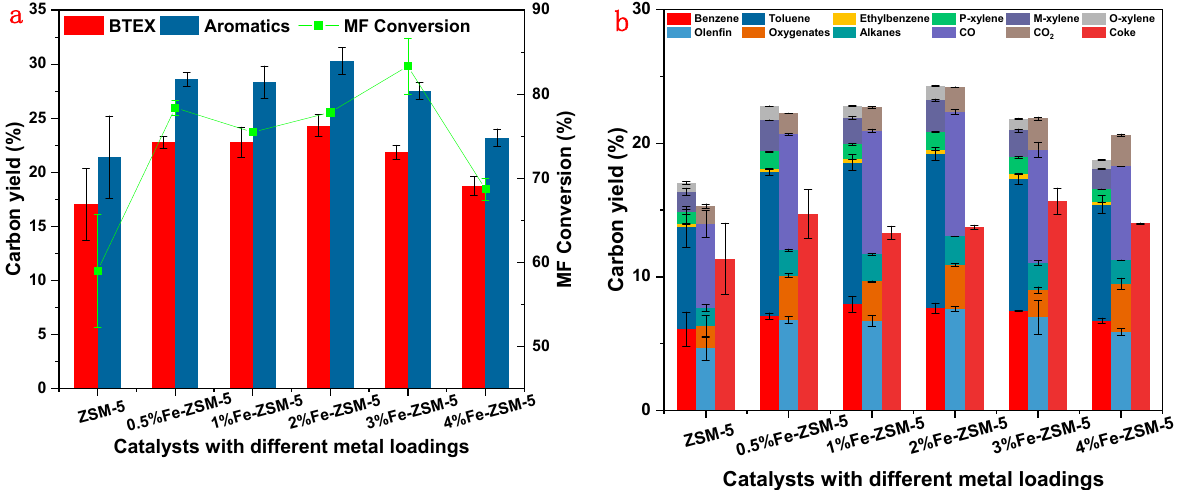
Figure 2. Effect of metal loadings on the product distribution from CFP of bio-derived MF: ( a ) carbon yields of BTEX, aromatics, and MF conversion; ( b ) carbon yields of benzene, toluene, ethylbenzene, xylene, olefins, oxygenates, alkane, CO, CO 2 , and coke. Reaction conditions: 550 ◦ C, WHSV: 4 h − 1 , carrier gas flow rate: 120 mL/min, reaction time: 15